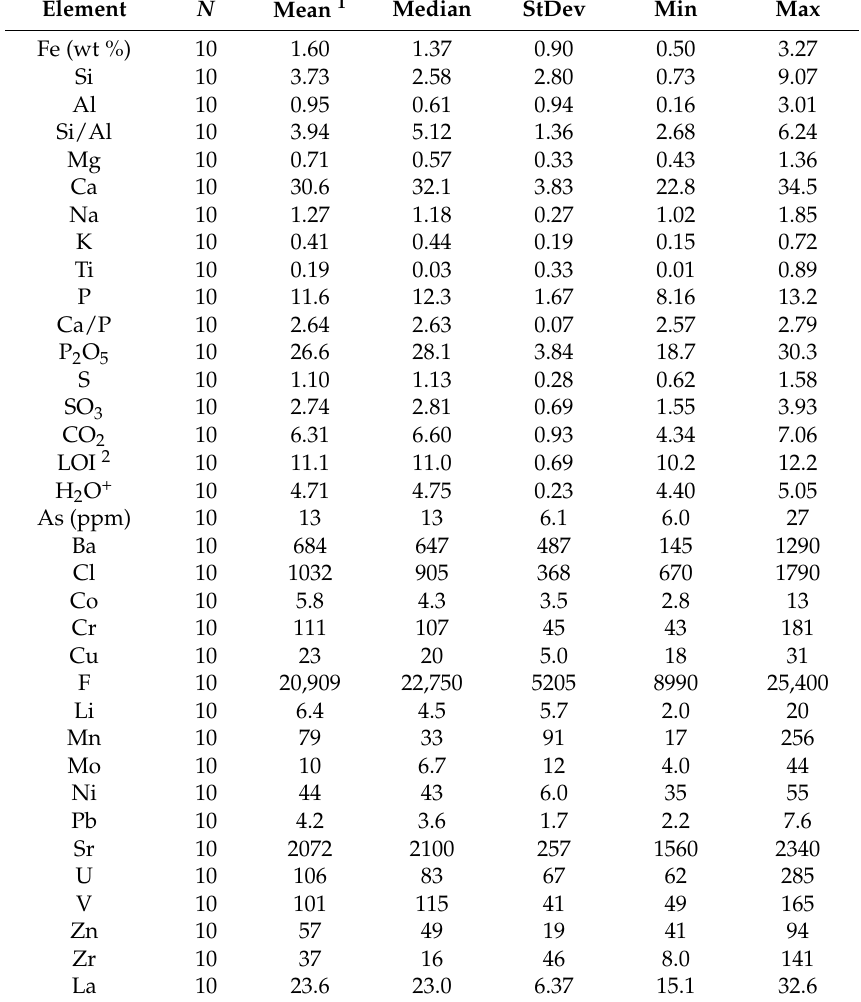
Table 3. Statistics of phosphorite deposits from the California Borderland (see Table S1 for full dataset). Element N Mean